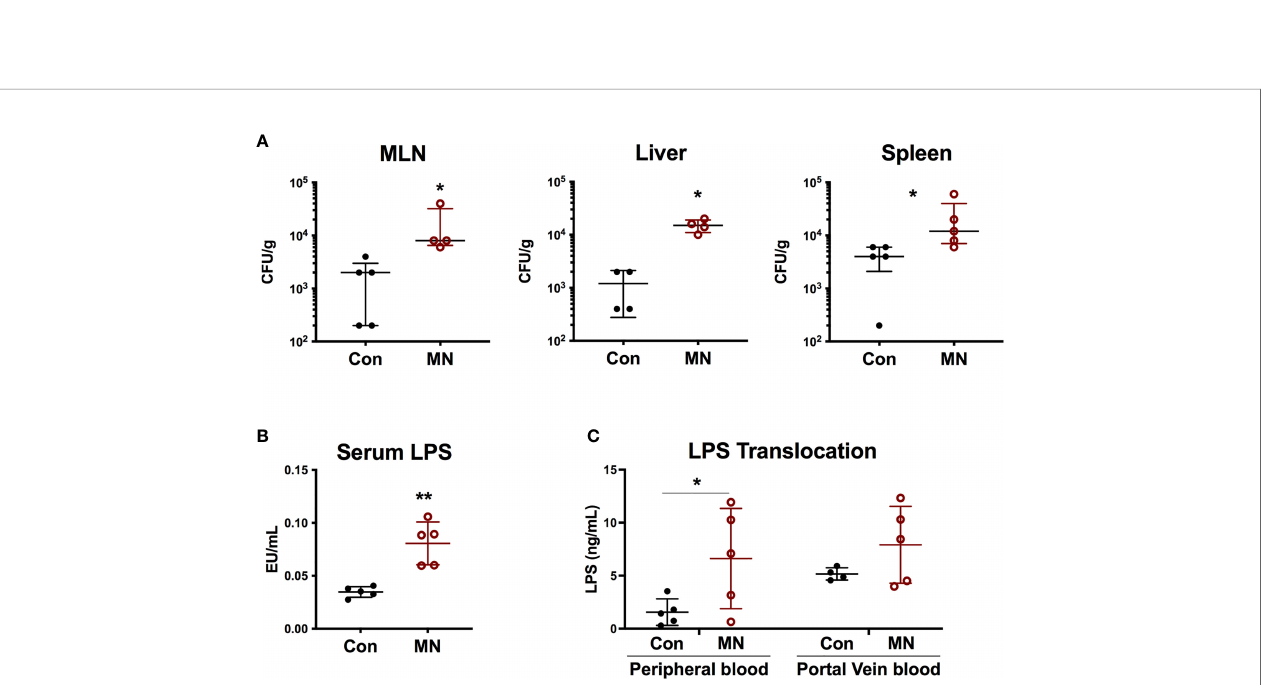
FIGURE 2 | Malnutrition promotes translocation of bacteria and bacterial LPS. (A) Quanti fi cation of culturable aerobic bacteria in the mesenteric lymph nodes (MLN), liver, and spleen of control (Con) and malnourished (MN) mice. Live bacteria were quanti fi ed by plating tissue homogenates on BHI agar (n=4-5 mice per group). Data are presented as the median with interquartile range. (B) Measurement of bioactive LPS in serum from peripheral blood collected from control and MN mice (n=5 mice per group). Determined by HEK-blue TLR4 bioassay. (C) Control and MN mice were administered 0.1 mg/kg body weight of Alexa Fluor488-labeled LPS by oral gavage. Two hours after administration, blood was taken from heart and portal vein. Fluorescence (Ex: 485 nm/Em: 520 nm) in sera was measured by fl uorometer to quantify LPS concentration (ng/mL AF488-LPS). (*p < 0.05; **p <